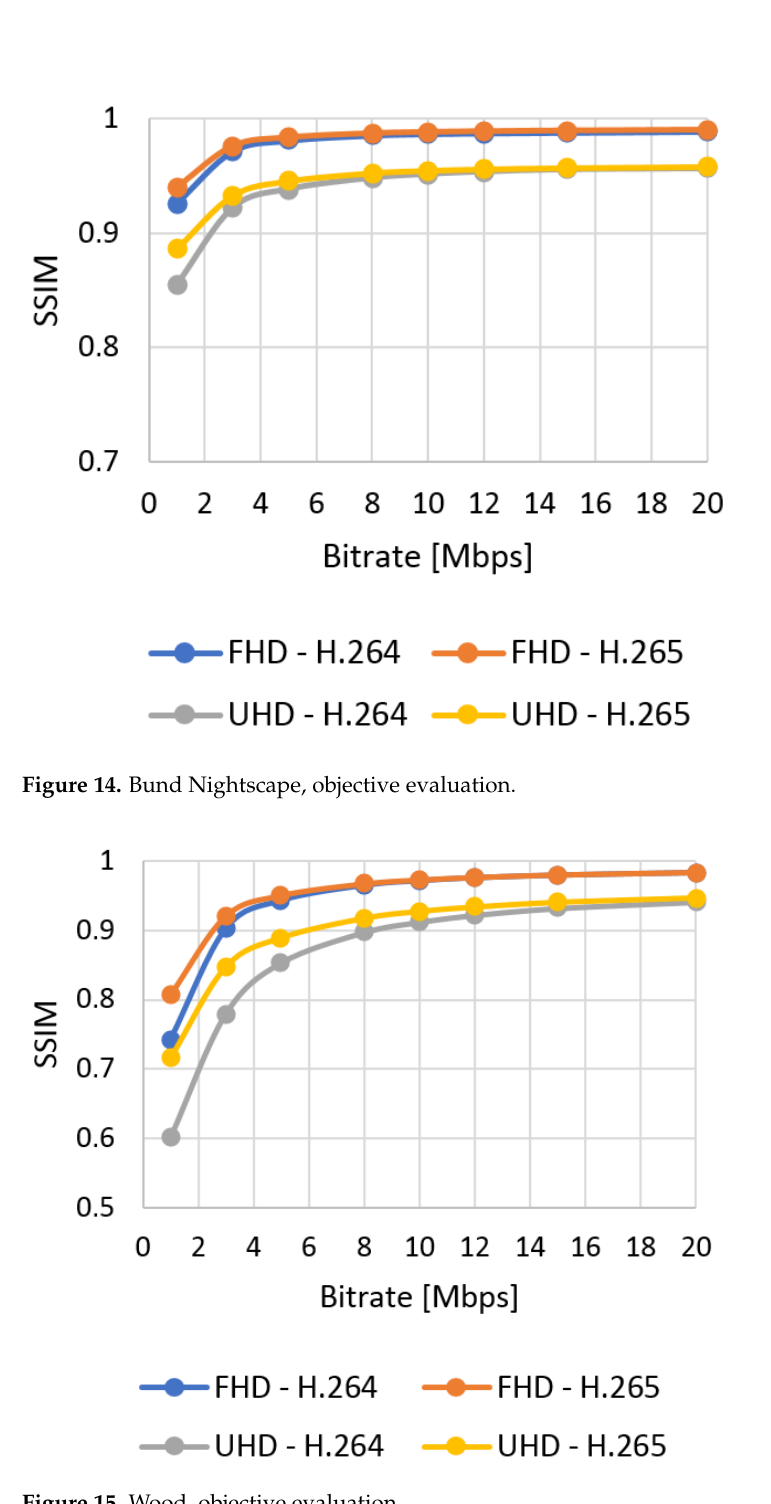
Figure 15. Wood, objective